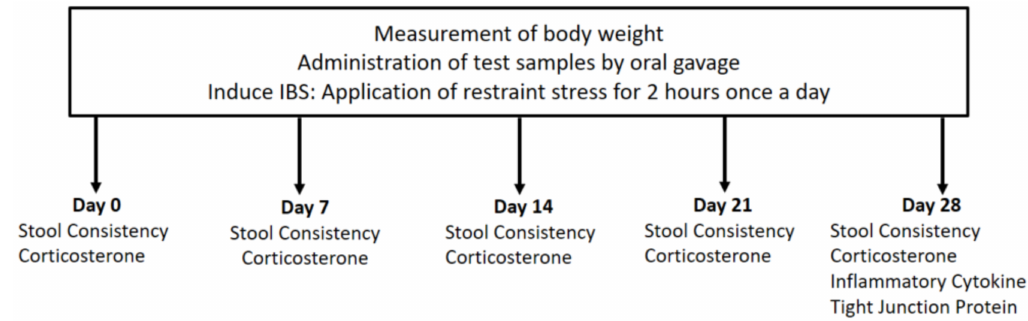
Figure 1. Schematic of this study